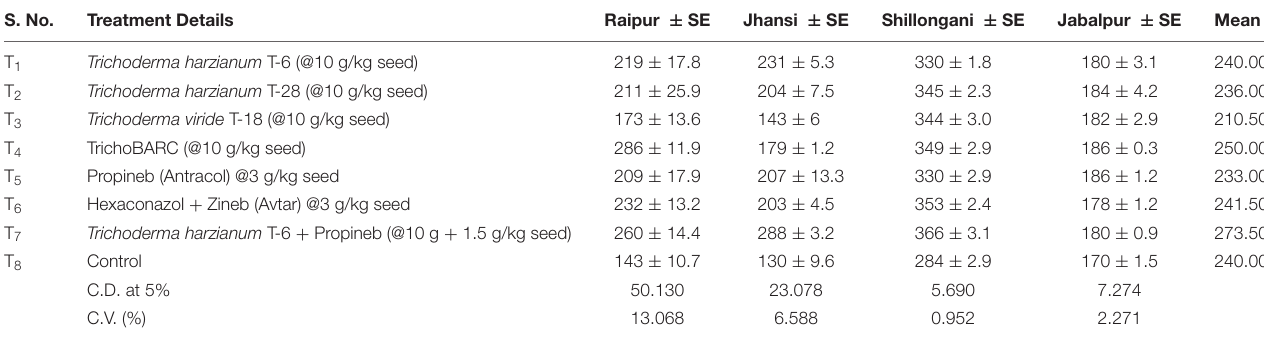
TABLE 3A | Evaluation of new stains of Trichoderma along with fungicides for the management of collar rot of chickpea (2018–2019) – Seedling emergence. S.